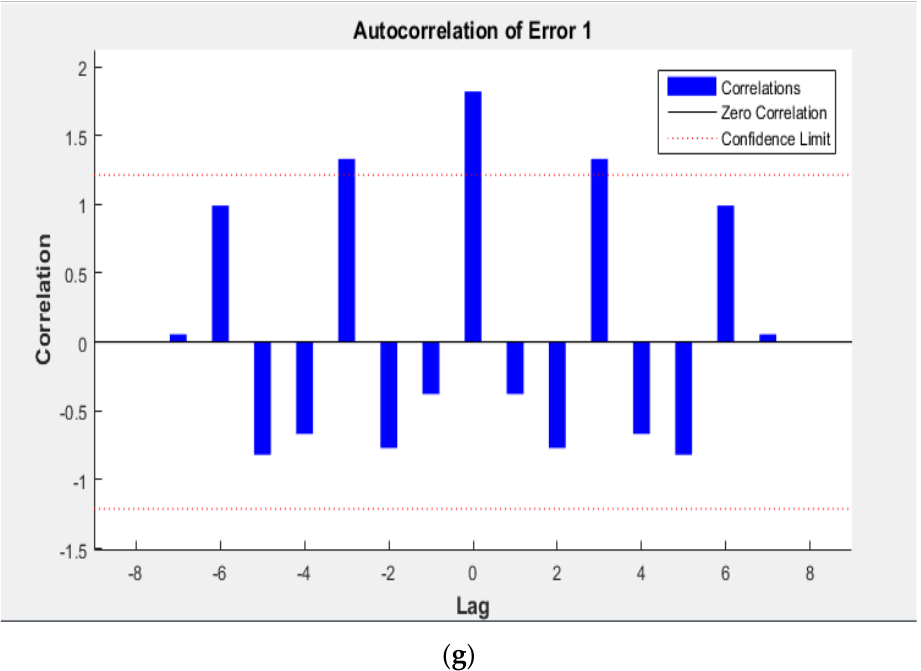
Figure 2. Bayesian regularization artificial neural network (BRANN) for urea adsorption. ( a ) Neural network overview; ( b ) training performance; ( c ) variation in gradient, training gain (mu) and vali- dation fail for epoch range 0 to 5; ( d ) error histograms with 20 bins; ( e ) response of output element; ( f ) results of curve fitting with variation in target; ( g ) autocorrelation of error with variation of lag.